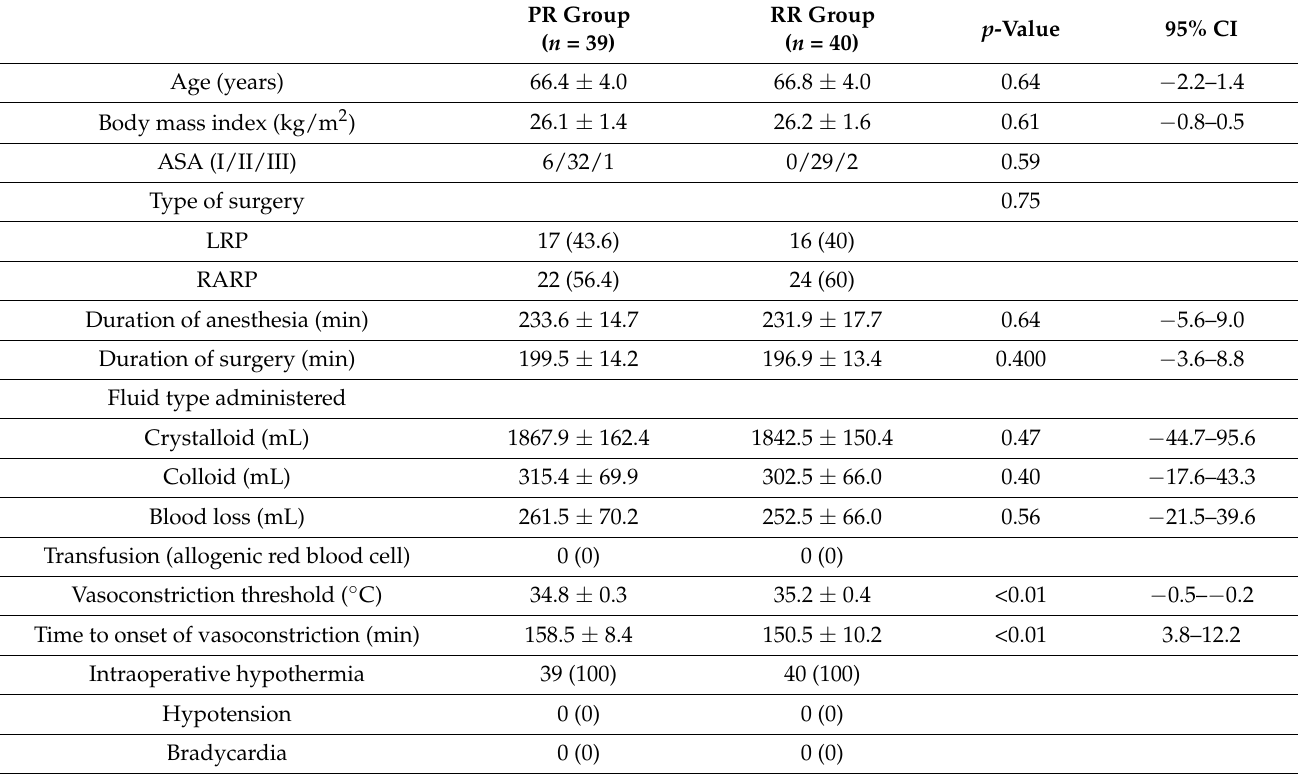
Table 1. Demographic and intraoperative data.